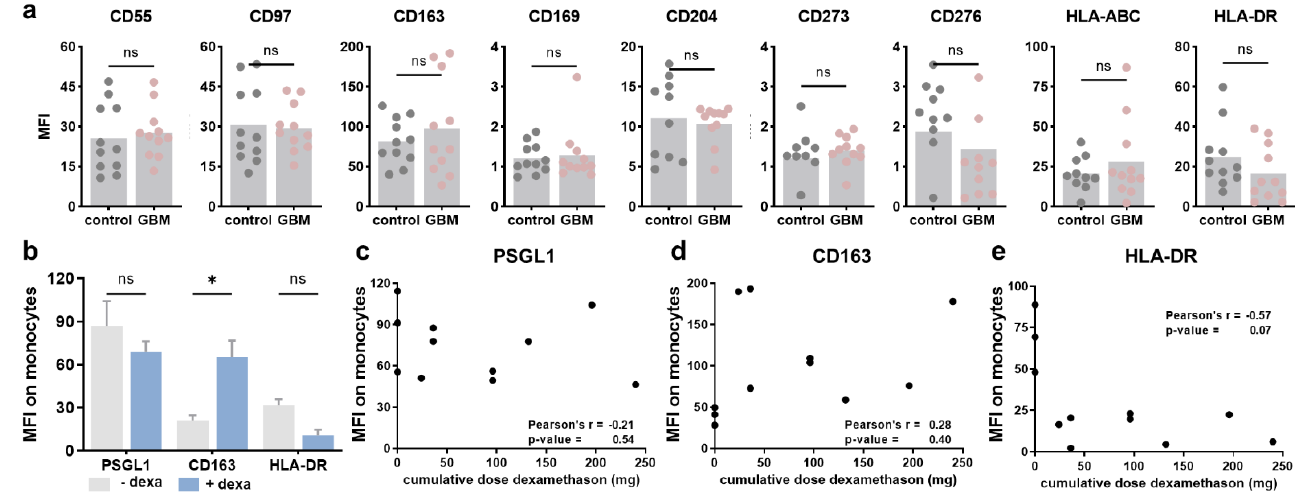
Figure A2. Immunophenotyping of circulating monocytes and impact of steroid medication. ( a ) mean fluorescence intensities (MFI) of CD55, CD97, CD163, CD169, CD204, CD273, CD276, HLA-ABC, and HLA-DR on circulating monocytes of glioblastoma patients (GBM) compared to healthy individuals; ( b ) quantification of PSGL-1, CD163, and HLA-DR expression on circulating monocytes in GBM patients with Dexamethasone medication or without; ( c – e ) Pearson's correlation of PSGL-1 ( c ), CD163 ( d ), or HLA-DR ( e ) expression with the cumulative doses of dexamethasone given to the GBM patients prior to blood withdrawal. Statistical analysis was performed using paired t -test (* p < 0.05). ns = non-significant. dexa = dexamethasone. Table A1. Previous medical history and medication. Summary of the previous medical history and medication of the GBM patients and age- and gender-matched control probands. COPD: chronic obstructive pulmonary disease. NSAIDs: non-steroidal anti-inflammatory drugs. Co-Morbidities GBM Patients Controls high blood pressure 17 19 atrial fibrillation 3 3 hypothyreosis 3 4 diabetes mellitus 8 4 hyperuricemia 1 1 retinal detachment 0 1 glaucoma 0 3 cataract 0 1 cardiovascualr diseases 3 6 dyslipidemia 4 2 COPD 2 4 0 depression medication hemostasis 11 13 NSAID's kidney insufficiency 2 0